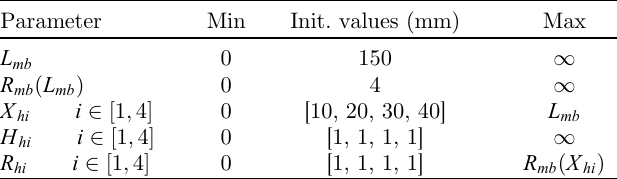
Table 3. Initial values of the different optimized geometric parameters and their